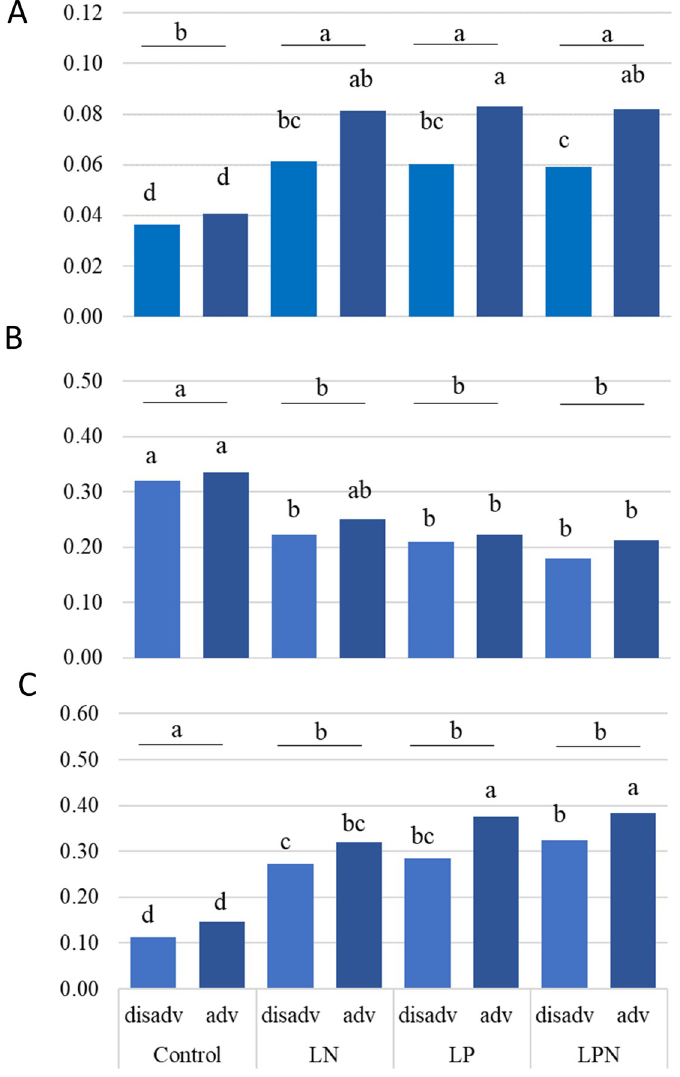
Fig 4. Root (A), shoot (B) and root to shoot ratio (C) from rice accessions harboring the advantageous or disadvantageous alleles for total panicle weight (TPW). Plants were grown under hydroponic condition with low Nitrogen and/or low Phosphorus (Experiment 2–2). Values are the mean of four independent biological replicates (n = 4). Statistical significance was determined using two-way ANOVA and Tukey’s tests. Different letters represent distinct means within groups at p < 0.05 ( ��� , �� , � , and ns refers to p < 0.001, 0.01, 0.05, non-significant, respectively). adv: advantageous allele (G-38, G-355, G-1103), disadv: disadvantageous allele (X265, IR64, G-61,